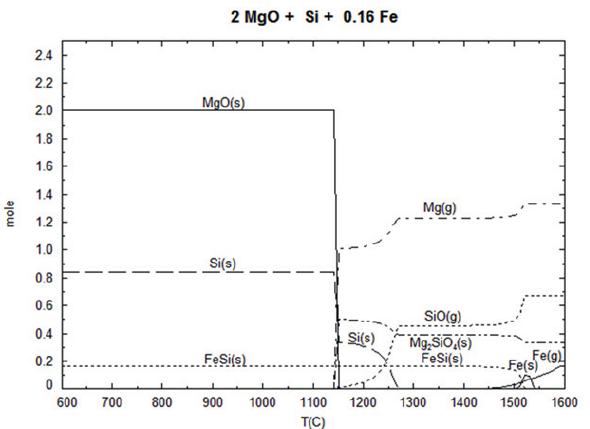
Figure 5. Simulation of Mg reduction considering the re- action 2MgO C Si under 1 (cid:2) 10 2 Pa at different tempera- tures [14].